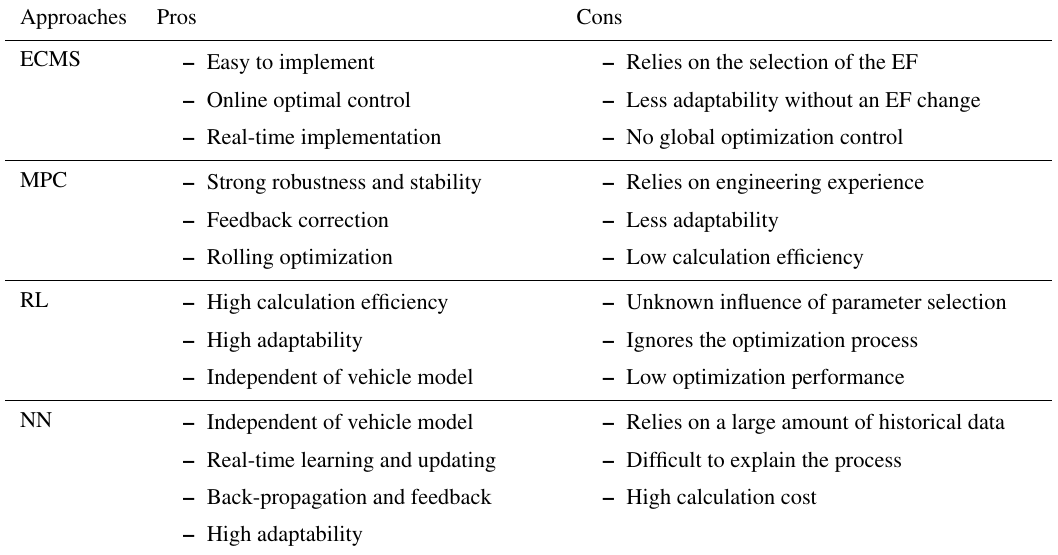
Table 10. A comparison of different methods applied to the instantaneous optimization